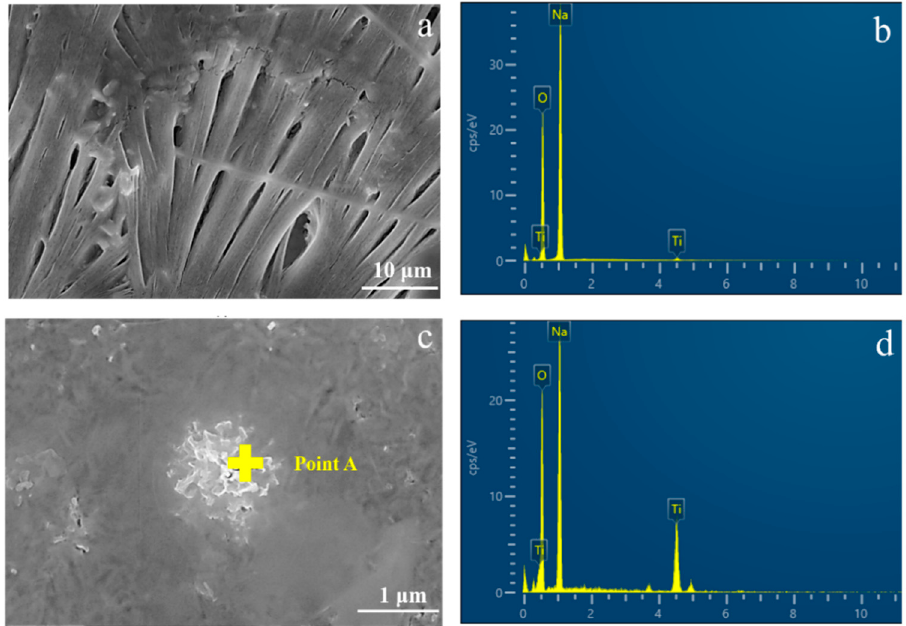
Figure 4. ( a ) Surface sweep of the needle-like structure observed in Figure 3c, along with ( b ) its EDS energy spectrum; ( c ) Point scan of the flower cluster-like structure observed in Figure 3c, along with ( d ) its EDS energy spectrum.